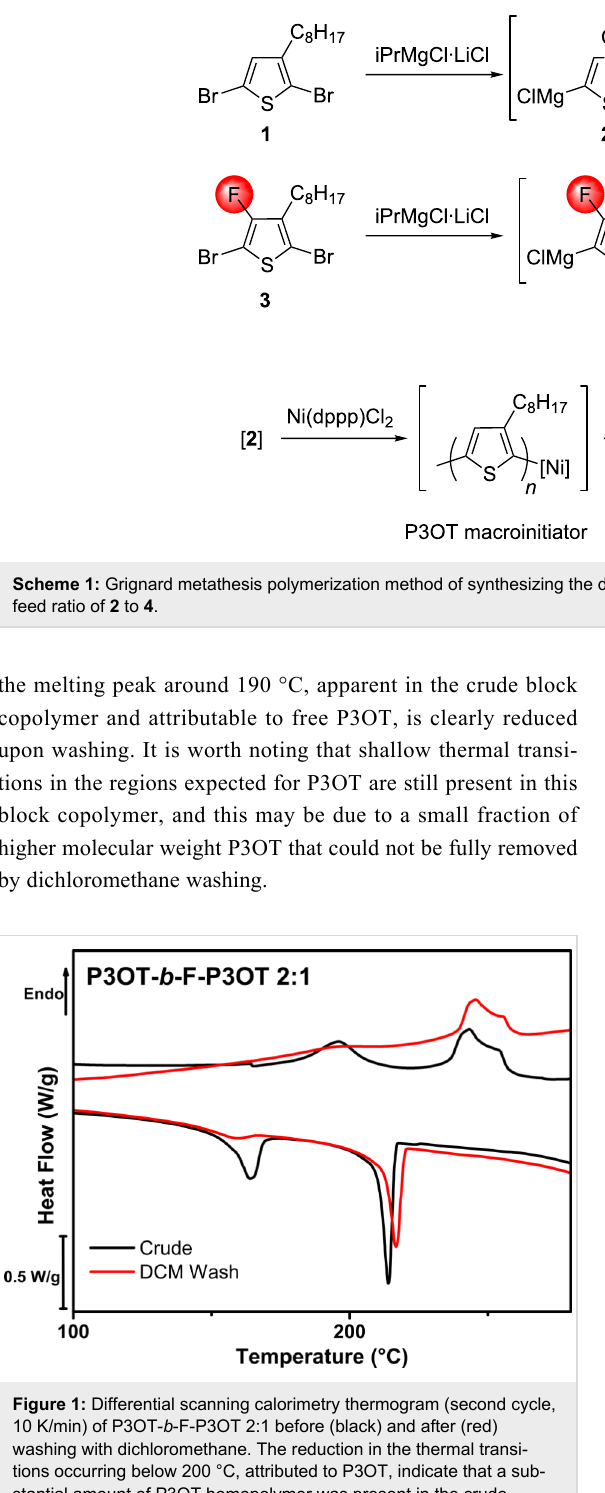
The true relative block lengths were calculated from the 1 H NMR spectra of the purified polymers, based on the